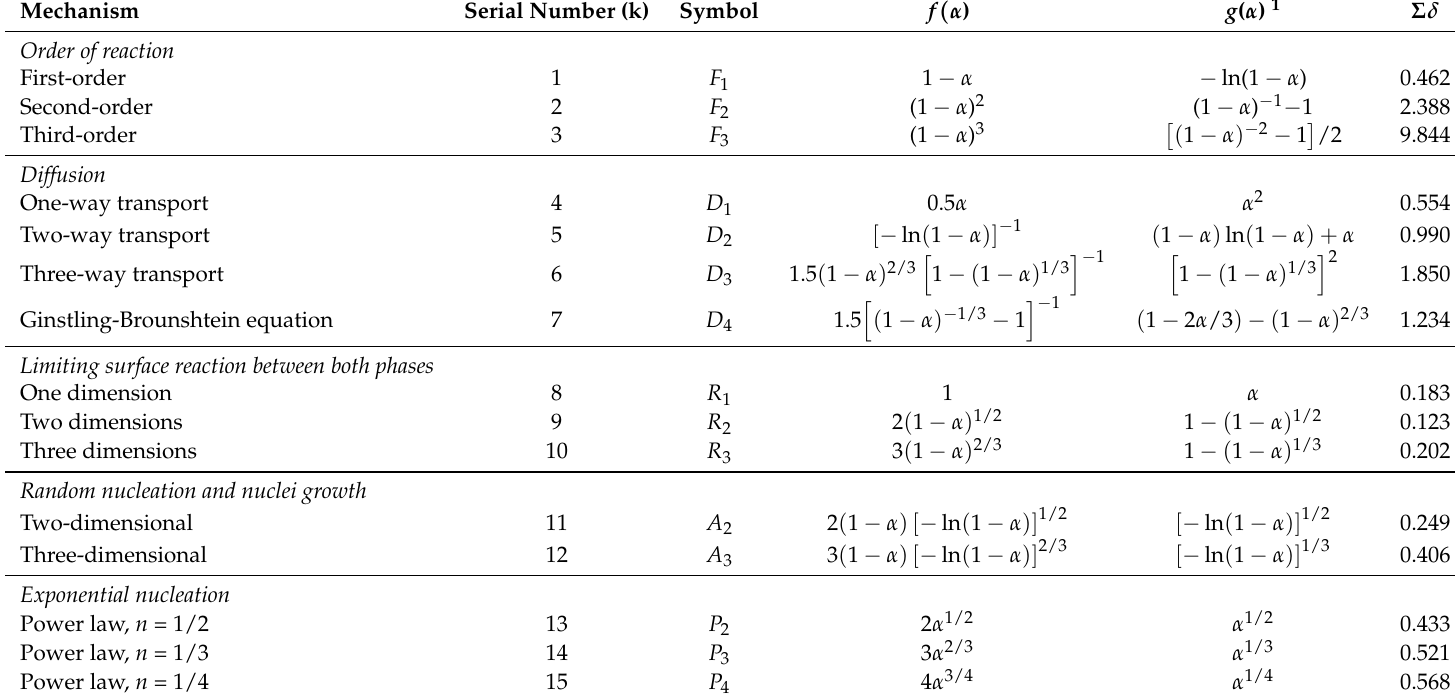
Table 1. Most frequent mechanism functions and their integral forms using in thermogravimetric analysis (TGA) kinetic with the sum of the standard deviations between the theoretical master and the experimental